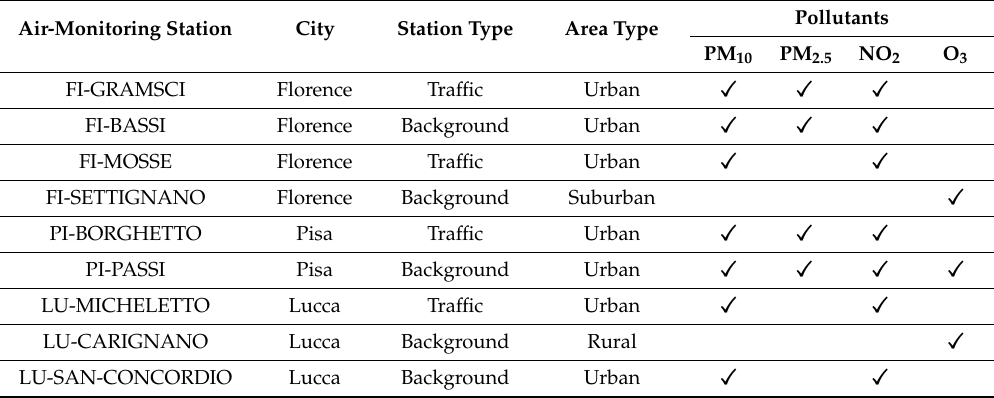
Table 1. Characteristics of the air-monitoring stations included in the